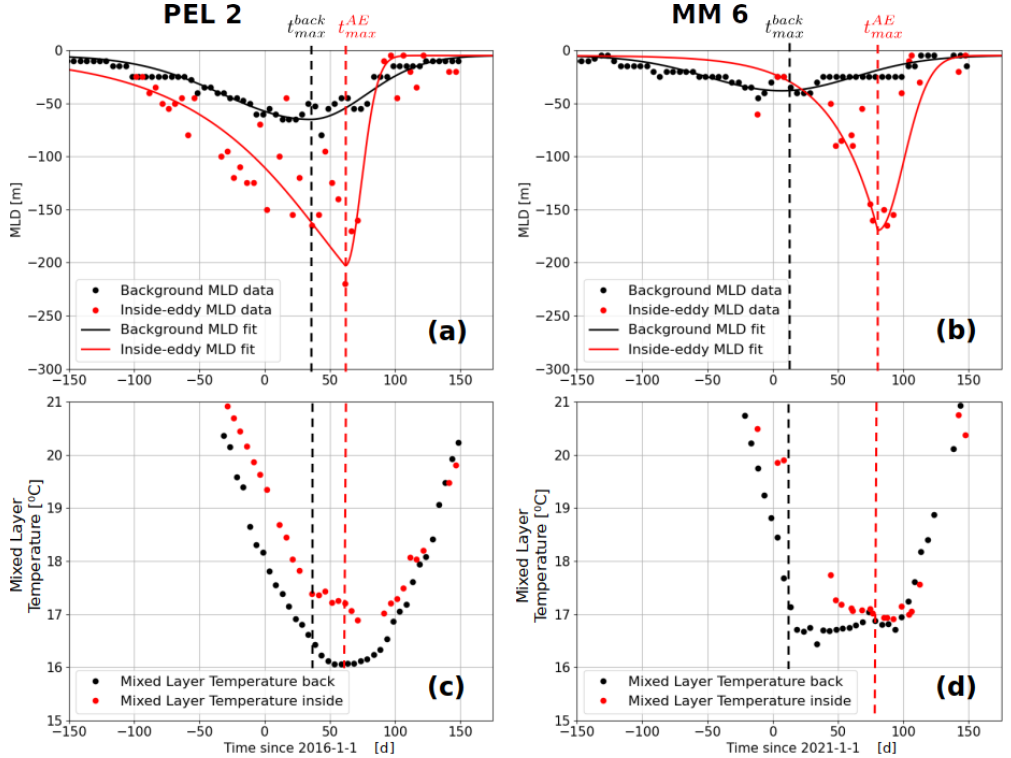
Figure 9. MLD data and fit for inside- and outside-eddy, illustrated for event PEL2 (a) and MM6 (b) (see Table 1). In the lower panel, corresponding mixed-layer temperature evolution for PEL2 (c) and MM6 (d) is shown. A dashed black (red) line marks the time of maximal background (inside-eddy)